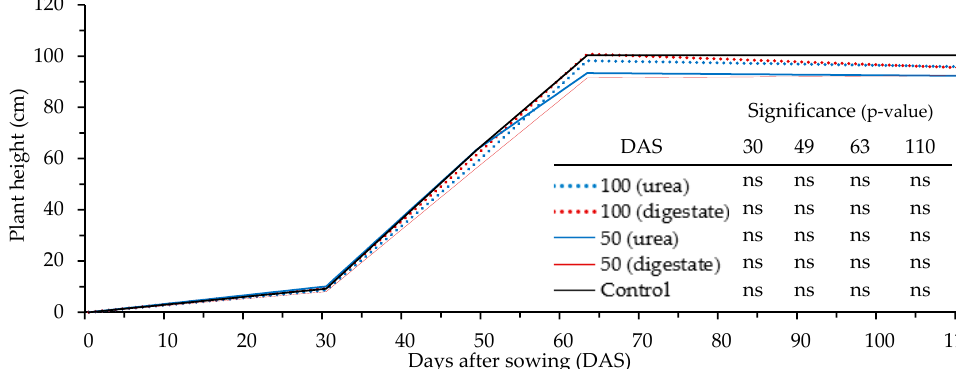
Figure 7. Evolution of plant height (cm) during the growing season for different N fertilization treatments (100/50 kg N ha − 1 urea, 100/50 kg N ha − 1 digestate, and 0 kg N ha − 1 -control). In terms of crop development, significant differences ( p < 0.05) between different levels of N fertilization were noted at the timing of fertilization (28 and 49 DAS) or right after. First, some